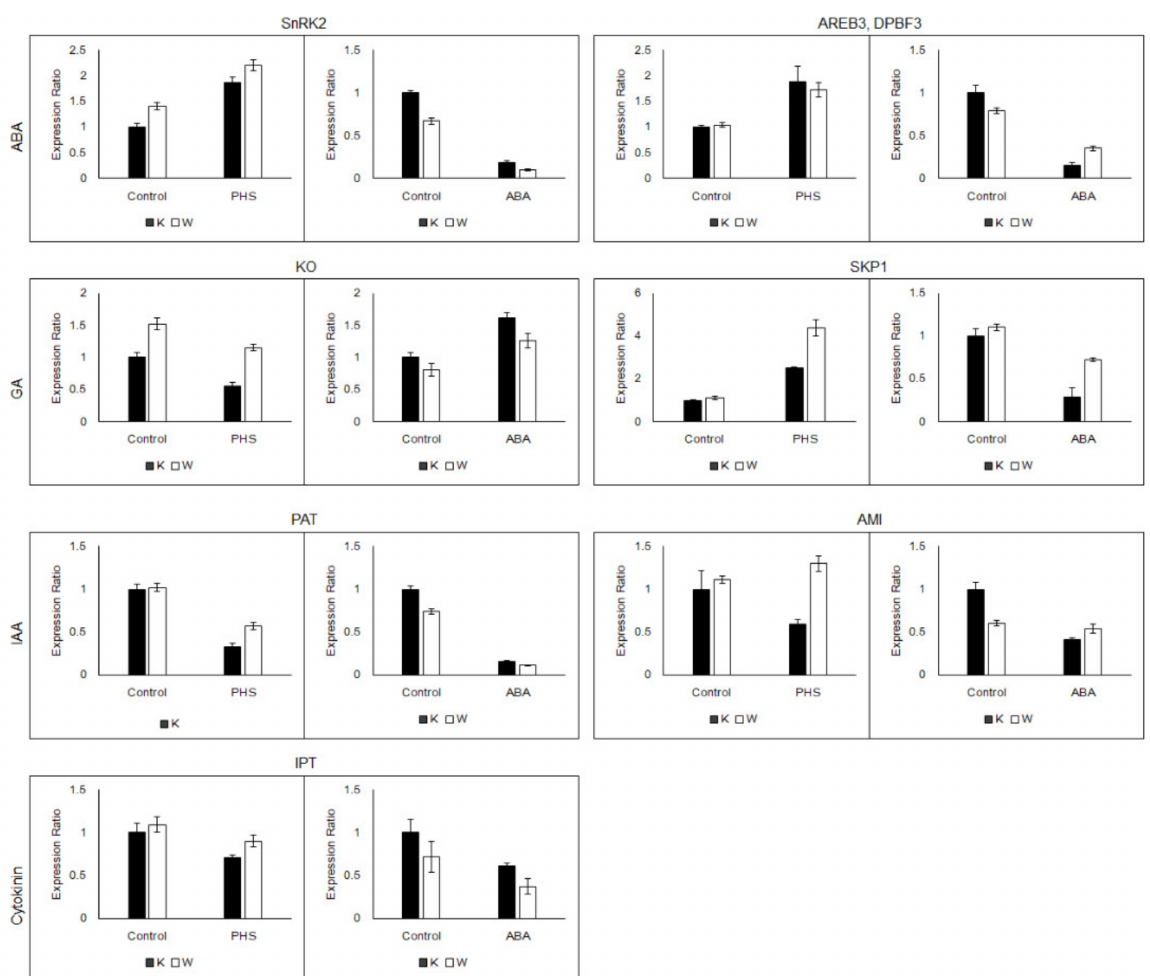
Figure 6. Validation of selected DEGs for ABA, GA, IAA, and cytokinin by quantitative real-time